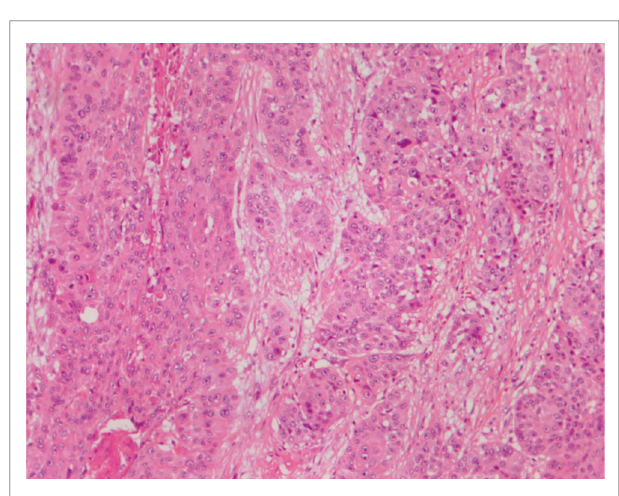
FIGURE 2 | ( A ) UGT1A8 _ex5c.1447T>G(p.Tyr483Asp)NCBI reference sequence: CTGGTACCAG TACCATTCCTTG; ( B ) UGT1A1 _ex1c.211G>A(p.Gly71Arg) NCBI reference sequence: CATCAGAGAC GGAGCATTTTAC; ( C ) UGT1A4 _ex1c.395T>C(p.Leu132Pro) NCBI reference sequence: GTGGAGCTAC TGCATAATGAGG.